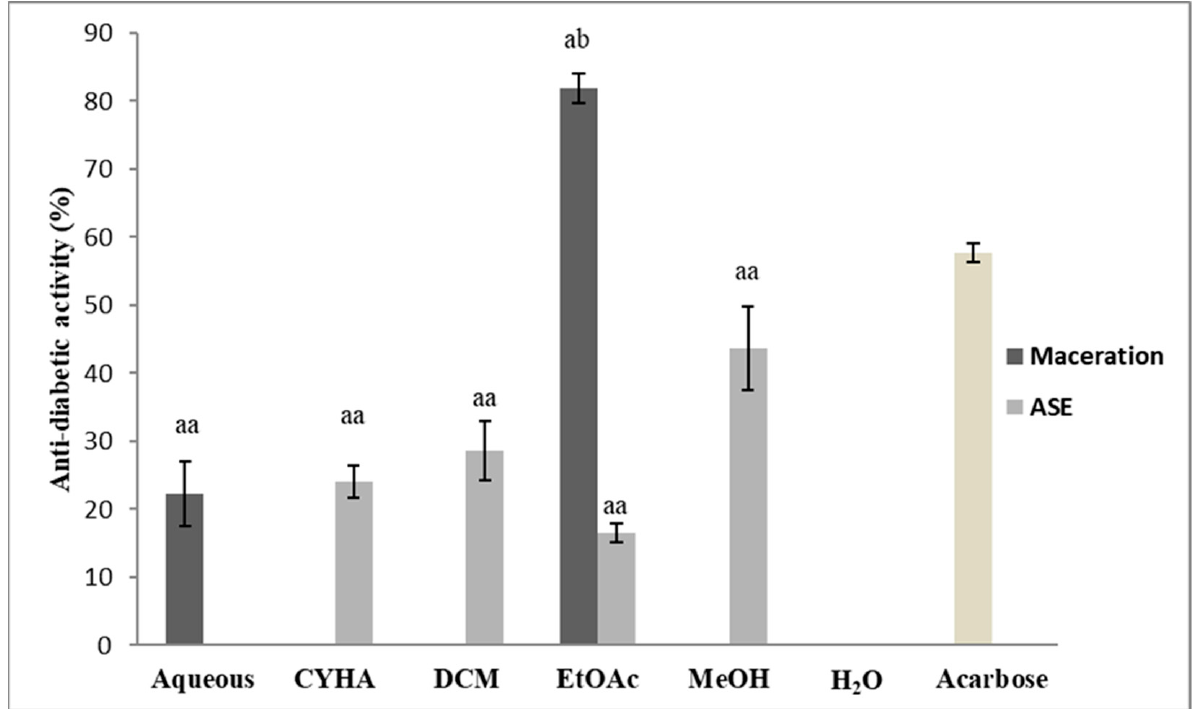
Figure 9. Antidiabetic Activity of different extracts of V. vinifera stem (CYHA: Cyclohexane; DCM: Dichloromethane; EtOAc: Ethyl acetate; MeOH: Methanol; Acarbose: used as reference at 50µg/mL). Extracts were tested at 50 µg/mL Means values ± SD ( n = 3); Different letter on the histograms means a significant difference ( p ≤ 0.05).